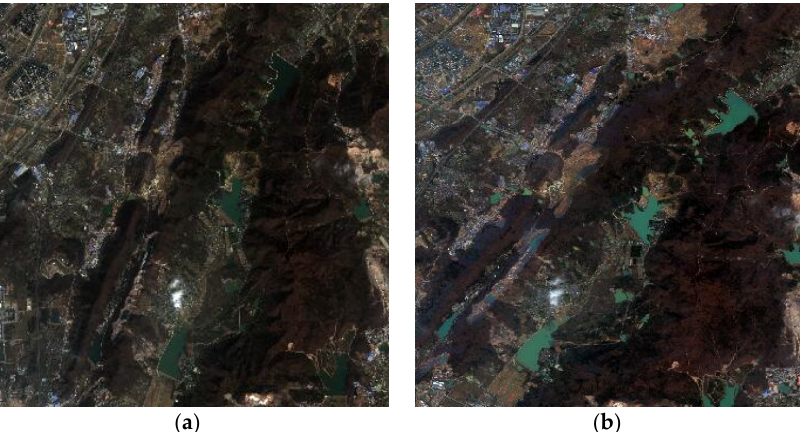
Figure 4. Comparison of multispectral images before and after fusion. ( a ) Original multispectral image; ( b ) image after fusion.